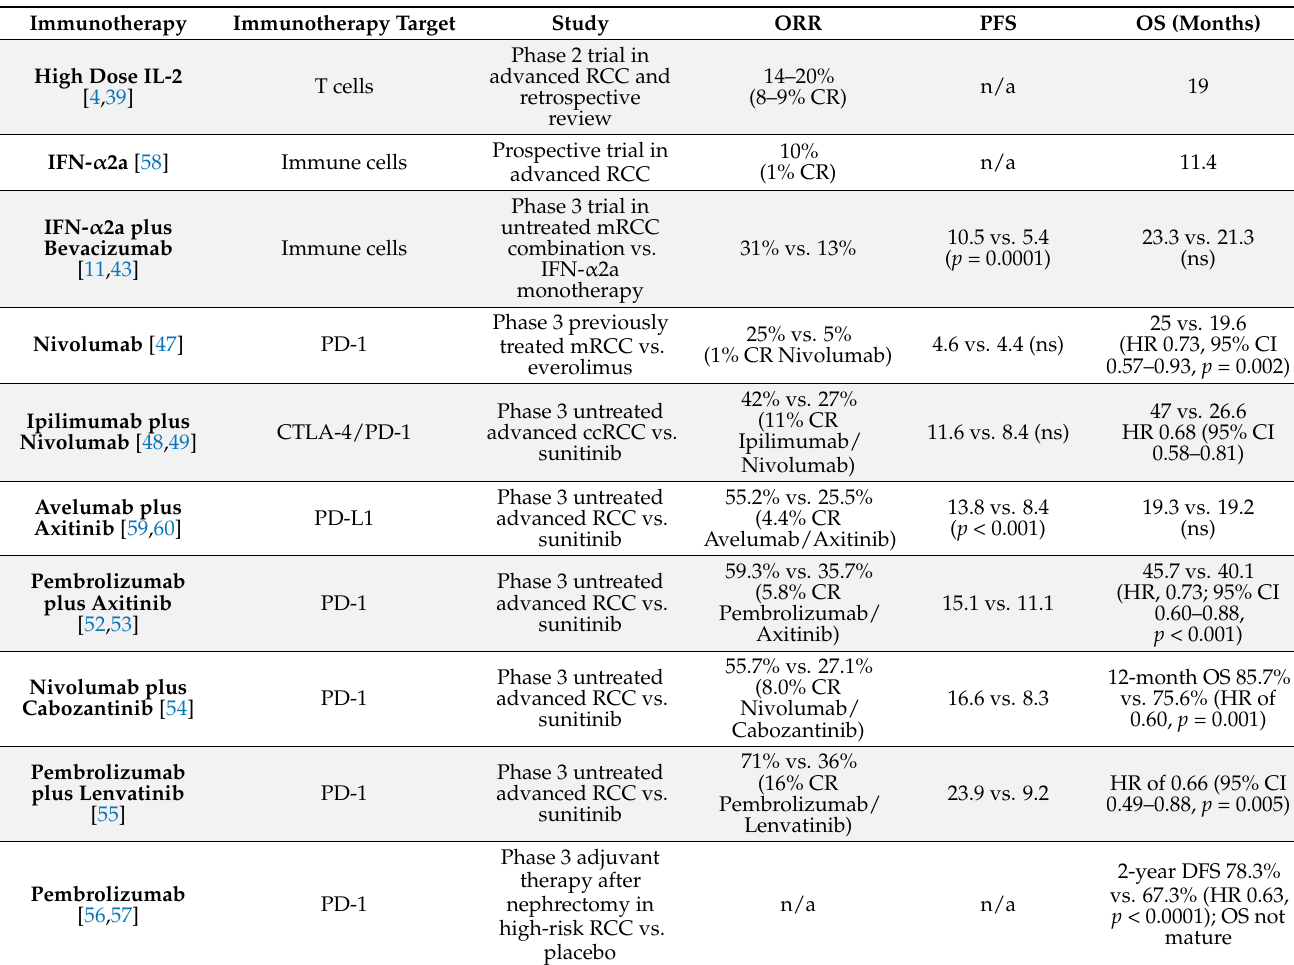
Table 2. FDA approved immunotherapy in patients with RCC. n/a, not